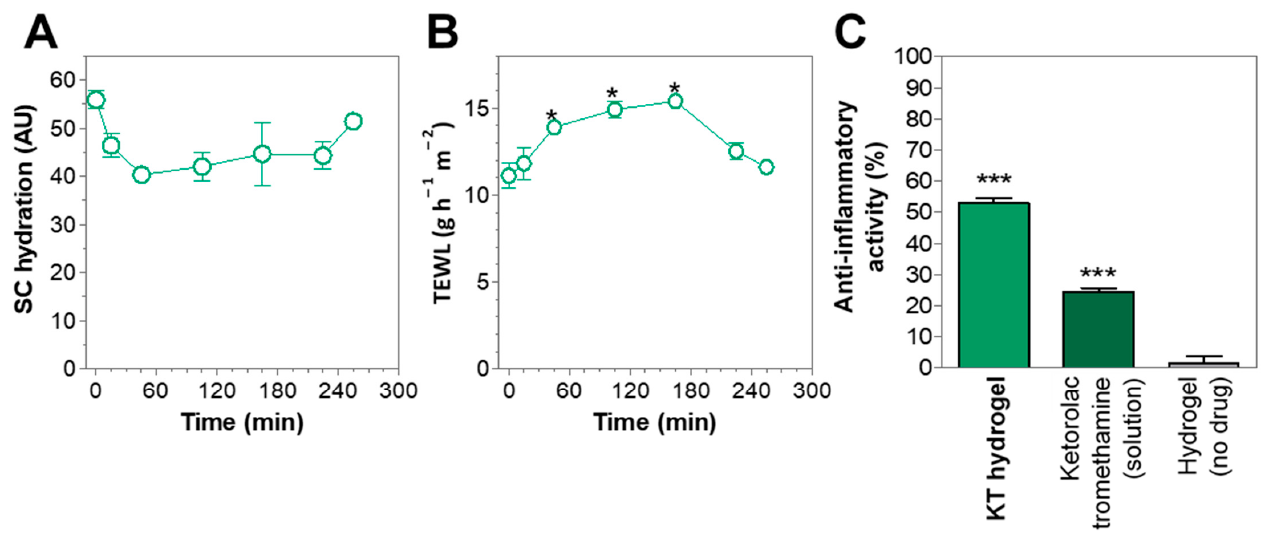
Figure 6. ( A ) Hydration of the stratum corneum upon application of KT hydrogel in humans. ( B ) Trans-epidermal water loss (TEWL) expressed in g of water per hour per m 2 of skin, upon application of KT hydrogel in humans. ( C ) Anti-inflammatory activity expressed as inhibition (%) of TPA-induced inflammation upon application of a treatment (KT hydrogel, ketorolac tromethamine in solution, and hydrogel without drug). Values represent Means ± SD ( n = 6). * Significant differences ( p < 0.05); *** Significant differences ( p < 0.001) as compared to control (hydrogel without drug).